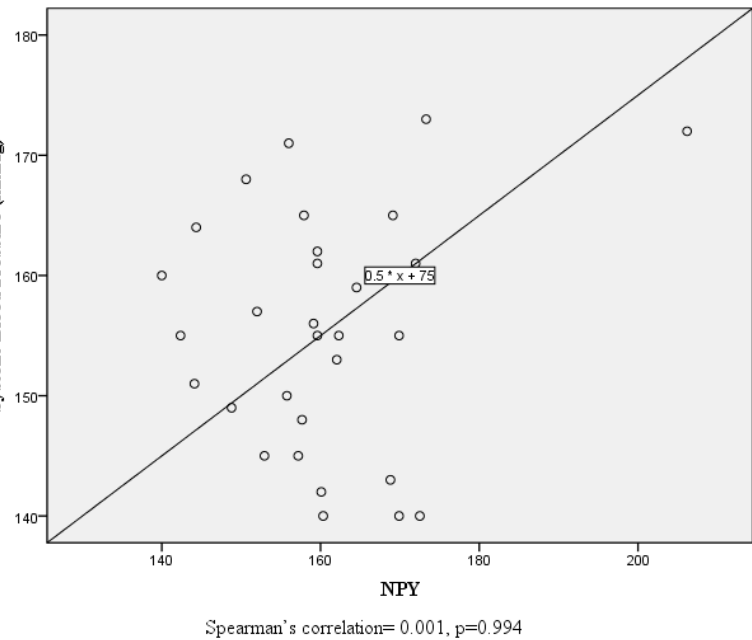
Figure 1. Scatter plot and correlation between systolic blood pressure and serum neuropeptide Y levels at baseline.